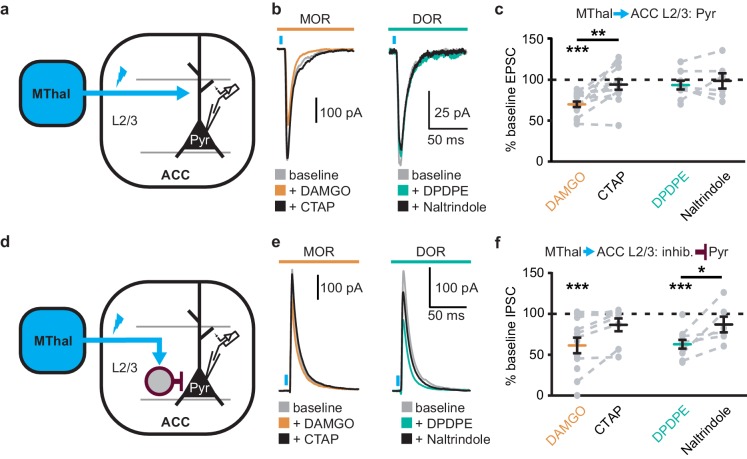
Opioid inhibition of synaptic currents onto layer 2/3 pyramidal neurons in the ACC.(a) Experimental diagram in which ChR2(H134R) (blue) was injected in the MThal, and oEPSCs were recorded from layer 2/3 (L2/3) pyramidal neurons (Pyr) in the ACC. (b) Example recordings of oEPSCs elicited from MThal terminals in the ACC. oEPSC amplitudes in response to DAMGO (1 µM, orange) followed by CTAP (1 µM, black) (left panel), and oEPSC amplitudes in response to DPDPE (1 µM, teal) followed by naltrindole (0.3 µM, black) (right panel). (c) Summary data of oEPSC amplitudes as described in (b), plotted as a percent of baseline. DAMGO: N = 8, n = 15; CTAP: N = 8, n = 12, SM = 18.148, p<0.001, IDAMGO: 69.3 ± 3.3% of baseline, W(15) = 0, p<0.001; DAMGO vs. CTAP, W(12) = 5, p<0.01; DPDPE: N = 7, n = 9; naltrindole: N = 6, n = 6, SM = 1.866, p=0.393. (d) Experimental diagram in which ChR2(H134R) (blue) was injected in the MThal, and oIPSCs were recorded from L2/3 pyramidal neurons in the ACC. (e) Example recordings of oIPSCs elicited from MThal terminals in the ACC under baseline conditions, in response to DAMGO and CTAP, or DPDPE and naltrindole as in (b). (f) Summary data of oIPSC amplitudes as described in (c, e), plotted as a percent of baseline. DAMGO: N = 7, n = 12; CTAP: N = 6, n = 8; SM = 8.882, p<0.05, IDAMGO: 61.2 ± 9.5% of baseline, W(12) = 1, p<0.001; DPDPE: N = 7, n = 10; naltrindole: N = 5, n = 6, SM = 13.329, p<0.01, IDPDPE: 62.7 ± 5.4% of baseline, W(10) = 0, p<0.01, DAMGO vs. CTAP, W(6) = 0, p<0.05. Skillings-Mack test followed by paired Wilcoxon signed-rank test post-hoc analysis. *p≤0.05; **p≤0.01; ***p≤0.001. Mean ± standard error of the mean. inhib.: inhibitory neuron; SM: Skillings-Mack statistic.